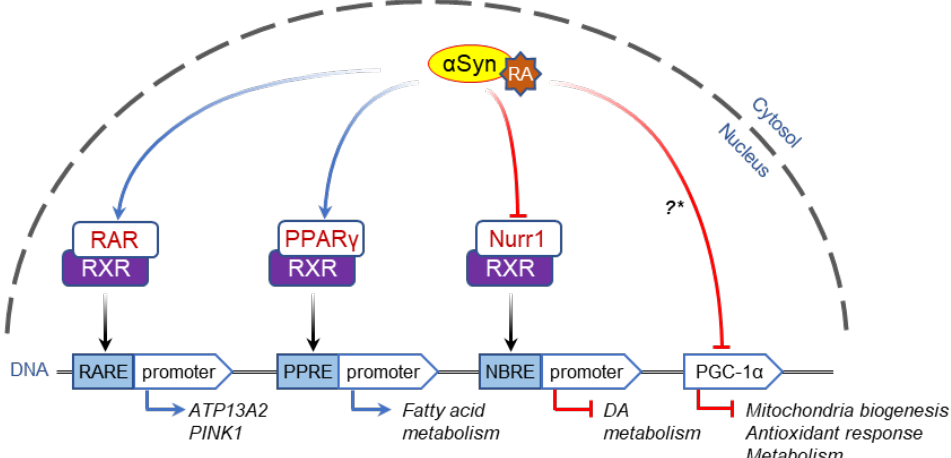
Figure 2. Effects of α -Syn on transcription factors. Left, α -Syn is translocated to the nucleus in a complex with retinoic acid (RA) where it interacts with and activates RAR and PPAR γ nuclear receptors, followed by activation of their corresponding response elements on gene promoter regions. Middle, overexpression of α -Syn also induces downregulation of the orphan nuclear receptor Nurr1, decreasing expression of Death Receptor 5 dependent genes, including those involved in dopamine biosynthesis ( TH , AADC, GCH1 ). Right, α -Syn binds the promoter region of PPAR γ co-activator (PGC-1 α ) gene when overexpressed. This leads to the downregulation of PGC-1 α transcription thus reducing cellular protection against oxidative stress and bioenergetic burden. *—It is currently unknown if the interaction with PGC-1 α is RA -dependent.